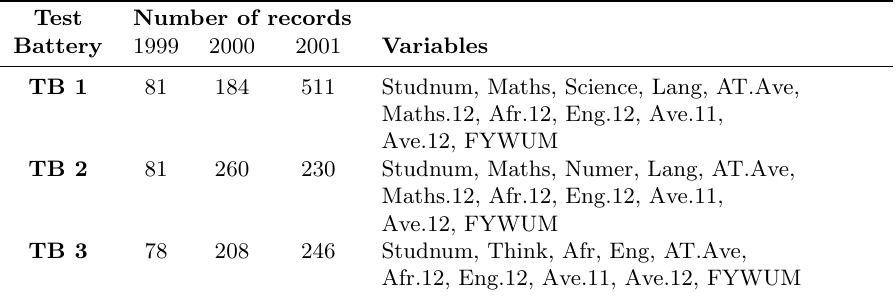
Table 2: Number of records and variables associated with the respective data